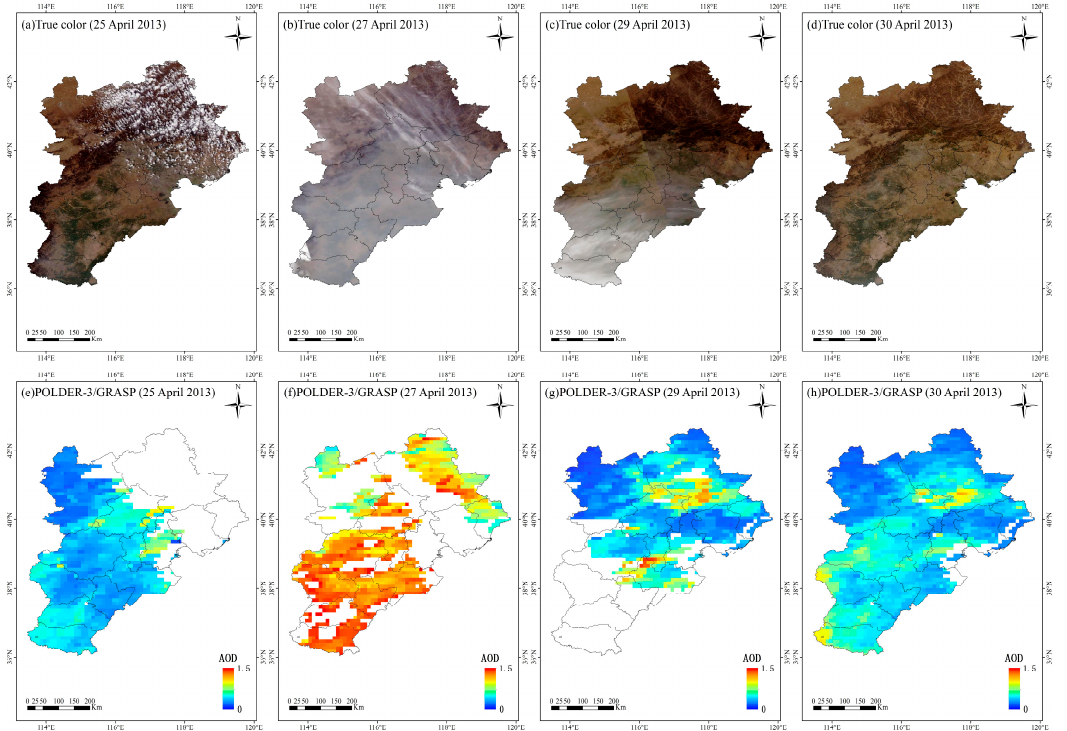
Figure 11. Distributions of one heavy pollution process in Beijing-Tianjin-Hebei region: ( a ) true color (25 April 2013); ( b ) true color (27 April 2013); ( c ) true color (29 April 2013); ( d ) true color (30 April 2013); ( e ) POLDER-3/GRASP (25 April 2013); ( f ) POLDER-3/GRASP (27 April 2013); ( g ) POLDER- 3/GRASP (29 April 2013); ( h ) POLDER-3/GRASP (30 April 2013) (true color figures are from Aqua MODIS; POLDER-3/GRASP products are AOD at 565 nm).